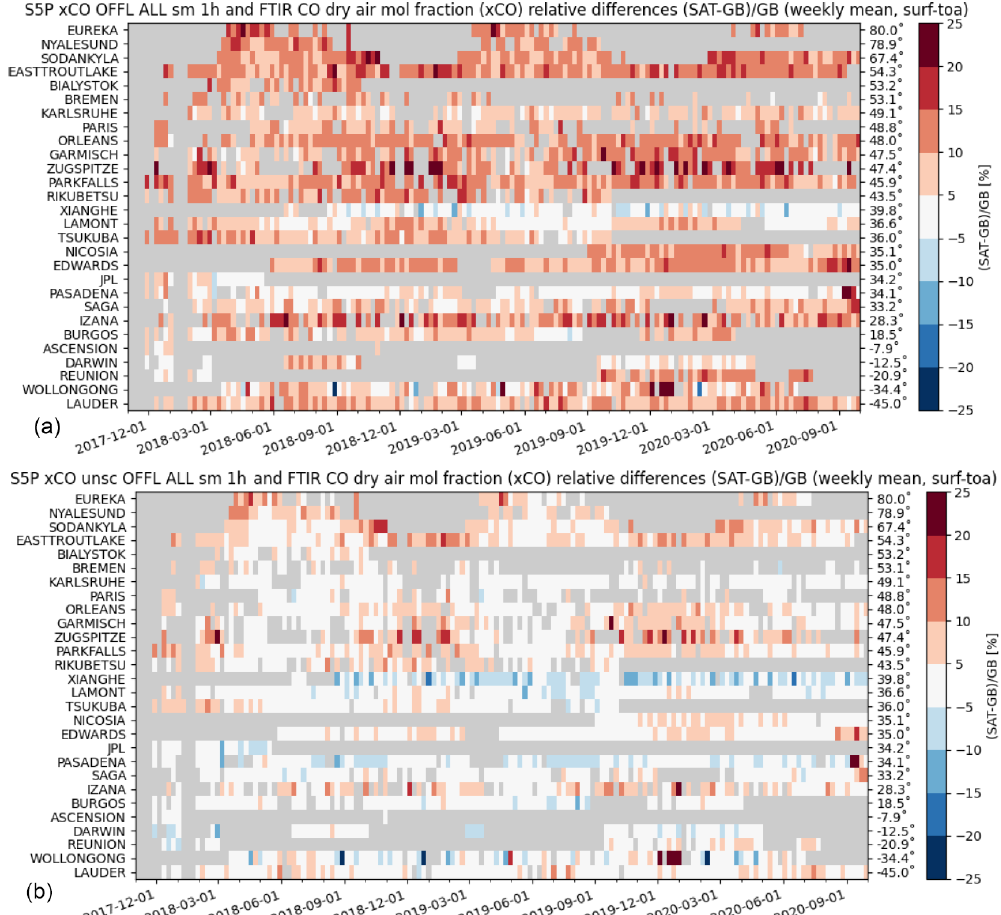
Figure 23. Mosaic plots showing relative biases between co-located S5P and TCCON XCO data with a priori alignment (standard – a ; unscaled – b ) at 28 TCCON stations within the period between November 2017 and September 2020. Spatial co-location with radius of 50km and time of ± 1h around the satellite overpass was used. The time resolution of the data shown here is weekly. The stations are sorted with decreasing